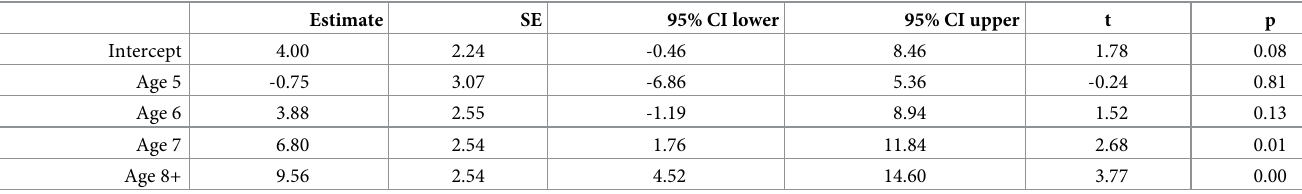
Table 4. Output for regression: Lister-Level � Age. Age is a dummy-coded, categorical predictor. Estimate Intercept